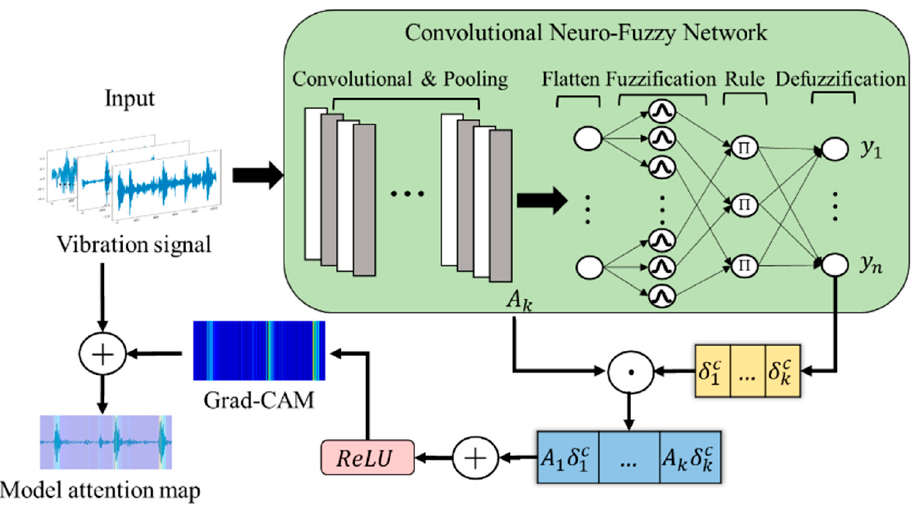
Figure 5. Flowchart of the GC-CNFN.